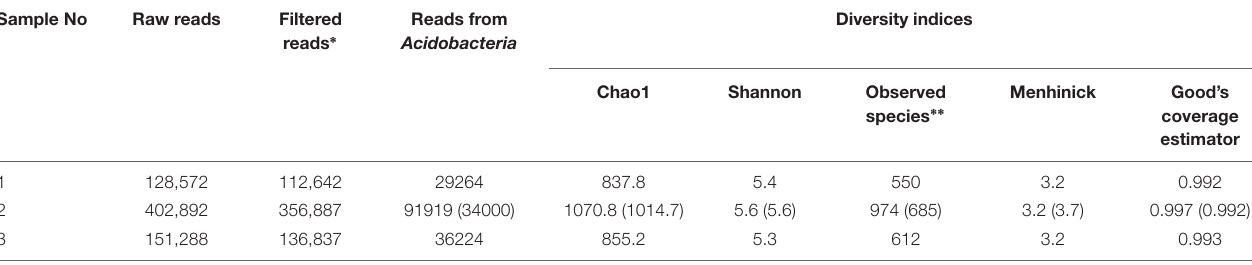
TABLE 1 | Sequencing statistics and various alpha-diversity metrics for the subset of 16S rRNA gene fragments assigned to the